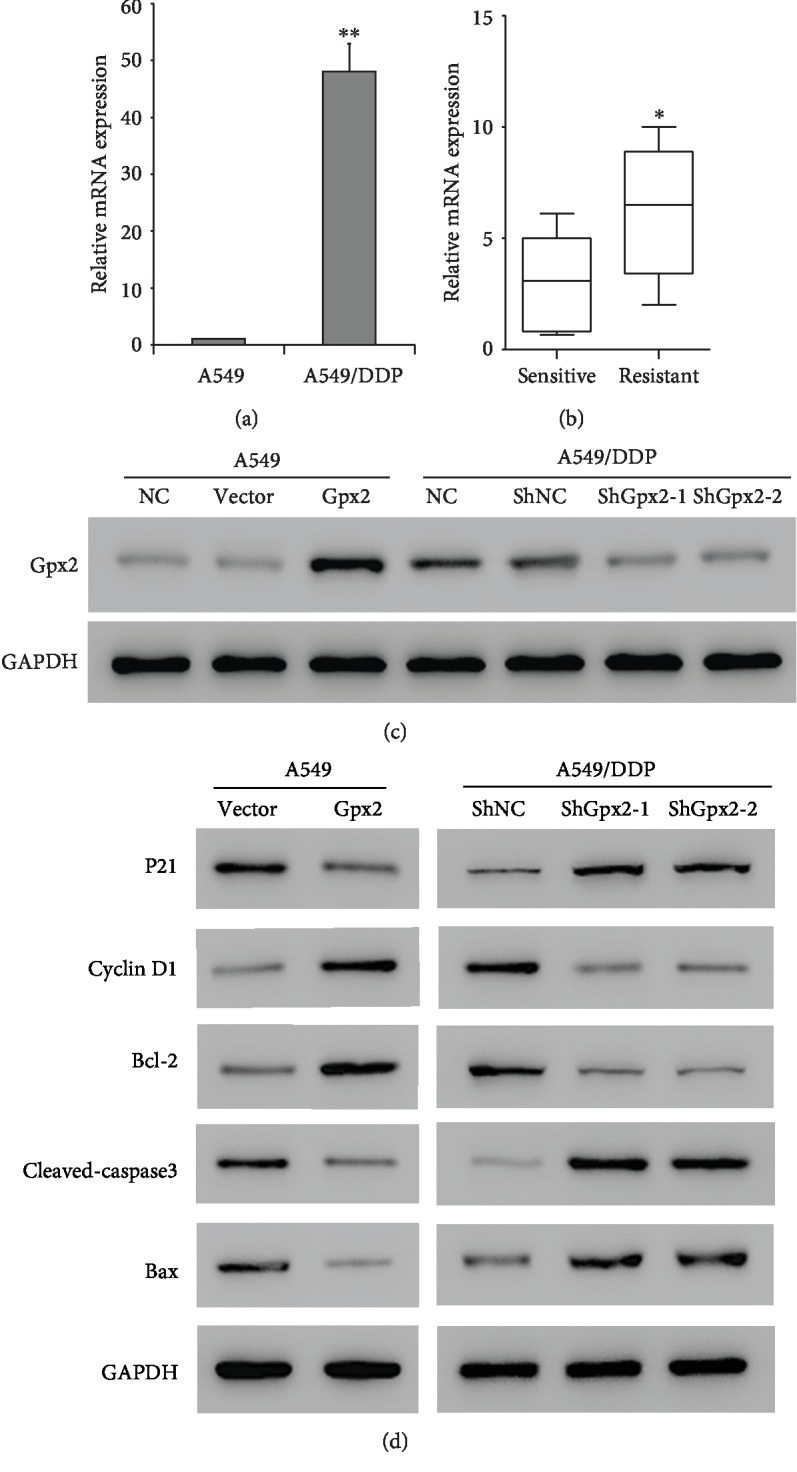
GPX2 expression of in cisplatin- (DDP-) resistant lung adenocarcinoma cell lines and tissues. The expression status of GPX2 in A549/DDP cells and the parental A549 cells was verified at the mRNA (a) and protein (c) levels. (b) GPX2 expression was analyzed in primary tumor cells; 20 LUAD samples were considered to be DDP-sensitive (IC50 < 5 mg/L), and 20 samples were considered to be DDP-resistant (IC50 > 10 mg/L). (c) Lentiviral vector-meditated shRNAs were used to knock down GPX2 expression in A549/DDP cells, and a GPX2 overexpressed vector was transfected into A549 cells. (d) Western blot analysis of the expression levels of cell cycle and apoptosis-related proteins. ∗p < 0.05 and ∗∗p < 0.001.